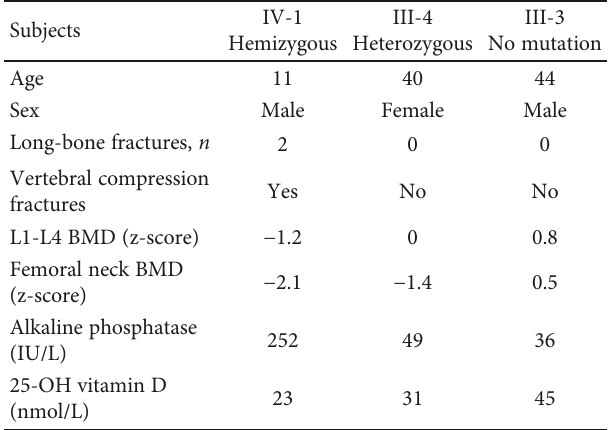
Table 1: Clinical characteristics, BMD scores, and biochemistry at the time of the fi rst